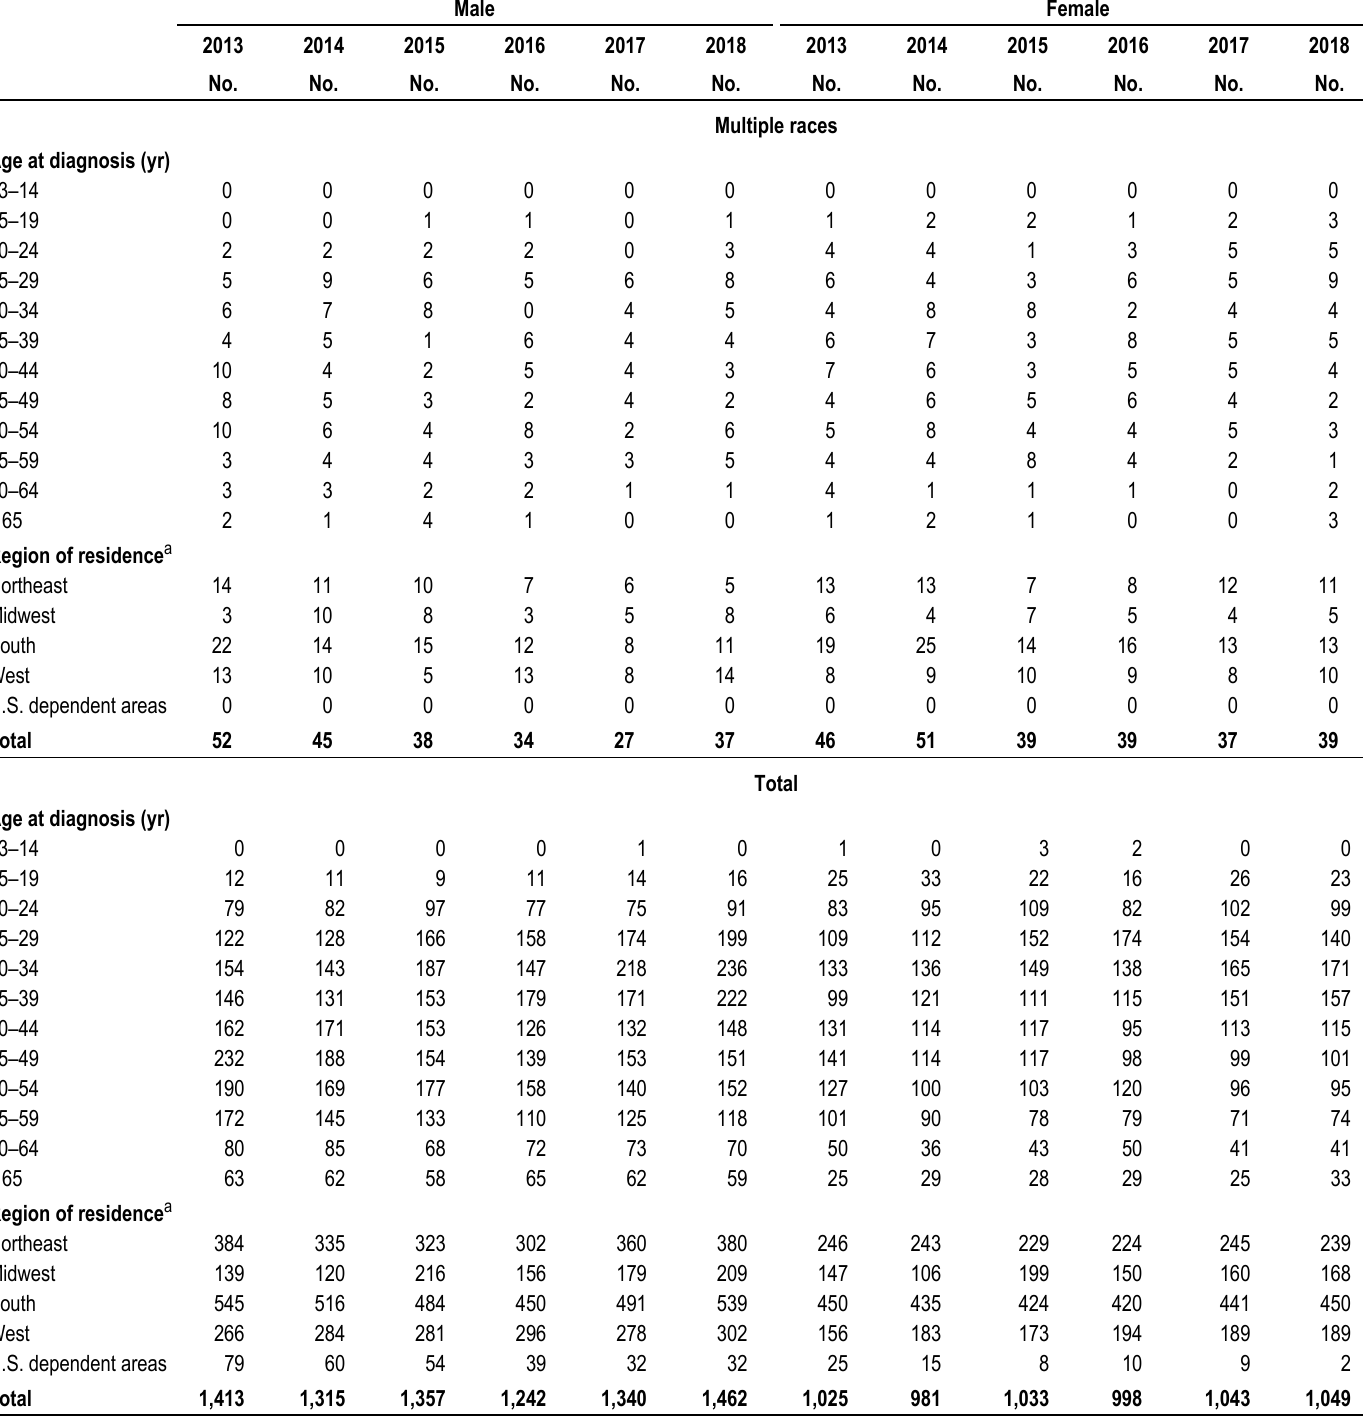
Table 8b. Diagnoses of HIV infection attributed to injection drug use, by selected characteristics, 2013–2018—United States and 6 dependent areas